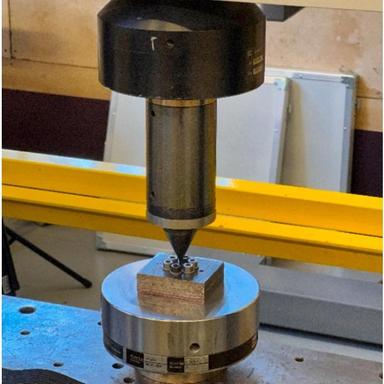
SPT experimental test setup.